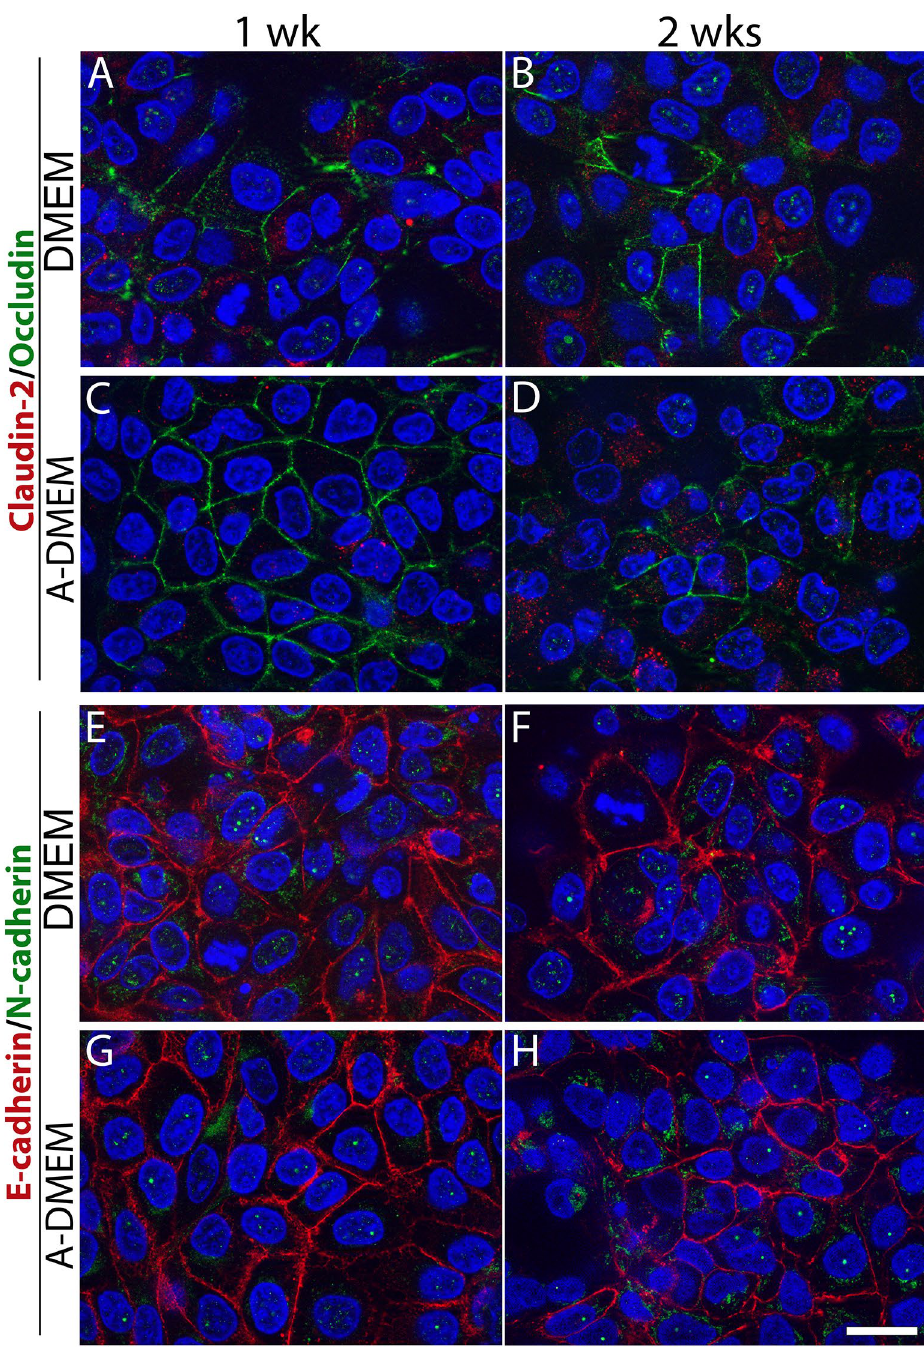
Figure 11. Expression of junctional proteins in submerged FLO-1 models. FLO-1 cells were maintained in DMEM or A-DMEM medium for 1 and 2 wks. Double immunofluorescence labelling of claudin-2 and occludin ( A – D ) and E-cadherin and N-cadherin ( E – H ). FLO-1 cells express occludin (green, A – D ), and E-cadherin (red, E – H ) in areas with polygonal cells, but claudin-2 (red, A – D ) and N-cadherin (green, E – H ) are only weakly expressed. Occludin expression is higher in cells maintained in A-DMEM and after 1 wk in culture. Scale bar, 20